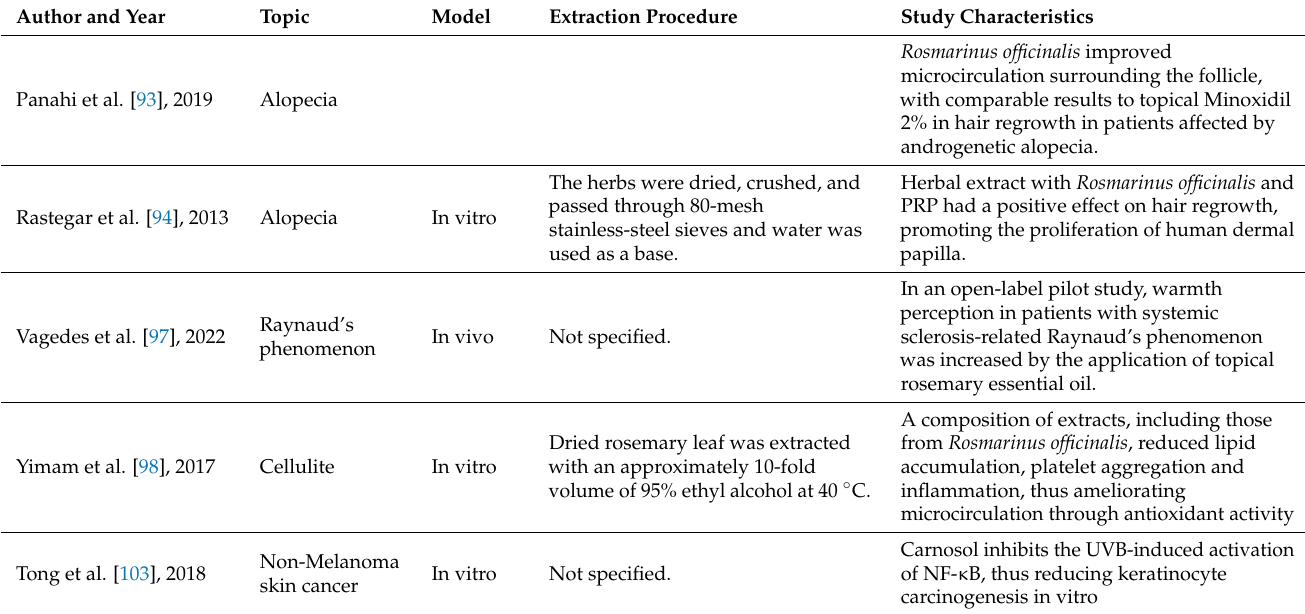
Table 4. The main findings regarding the role of Rosmarinus officinalis in cutaneous